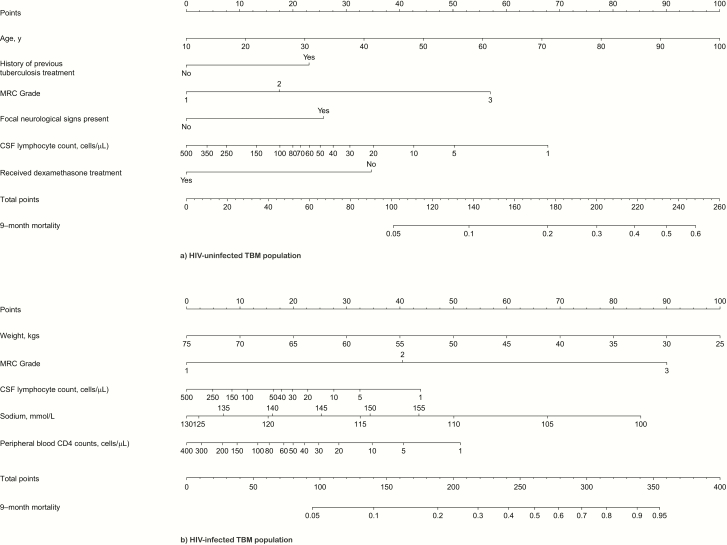
Nomograms for the prediction of 9-month mortality based on the final prognostic models for the tuberculous meningitis populations without (A) or with (B) human immunodeficiency virus (HIV) infection. To derive a prediction, locate the value of each predictor on the corresponding variable line, read the corresponding points assigned on the 0–100 scale, and sum all of these points to a total point score. Then read the result on the “total points” scale and its corresponding prediction below. For HIV-infected population, the cohort variable was chosen as the most recent trial [3], because this is most relevant for future prediction. Abbreviations: CSF, cerebrospinal fluid; HIV, human immunodeficiency virus; MRC, Medical Research Council; TBM, tuberculous meningitis.